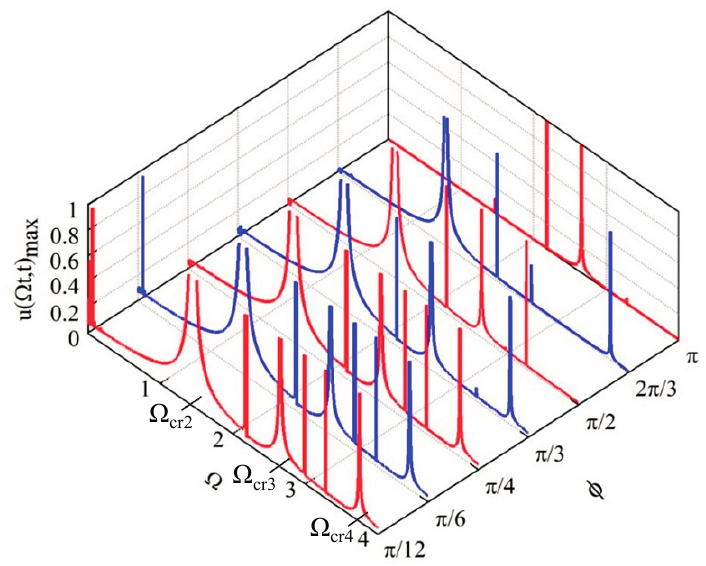
Figure 7. The maximum responses of the circular ring at the central point of the distributed traveling electrostatic force ( V =